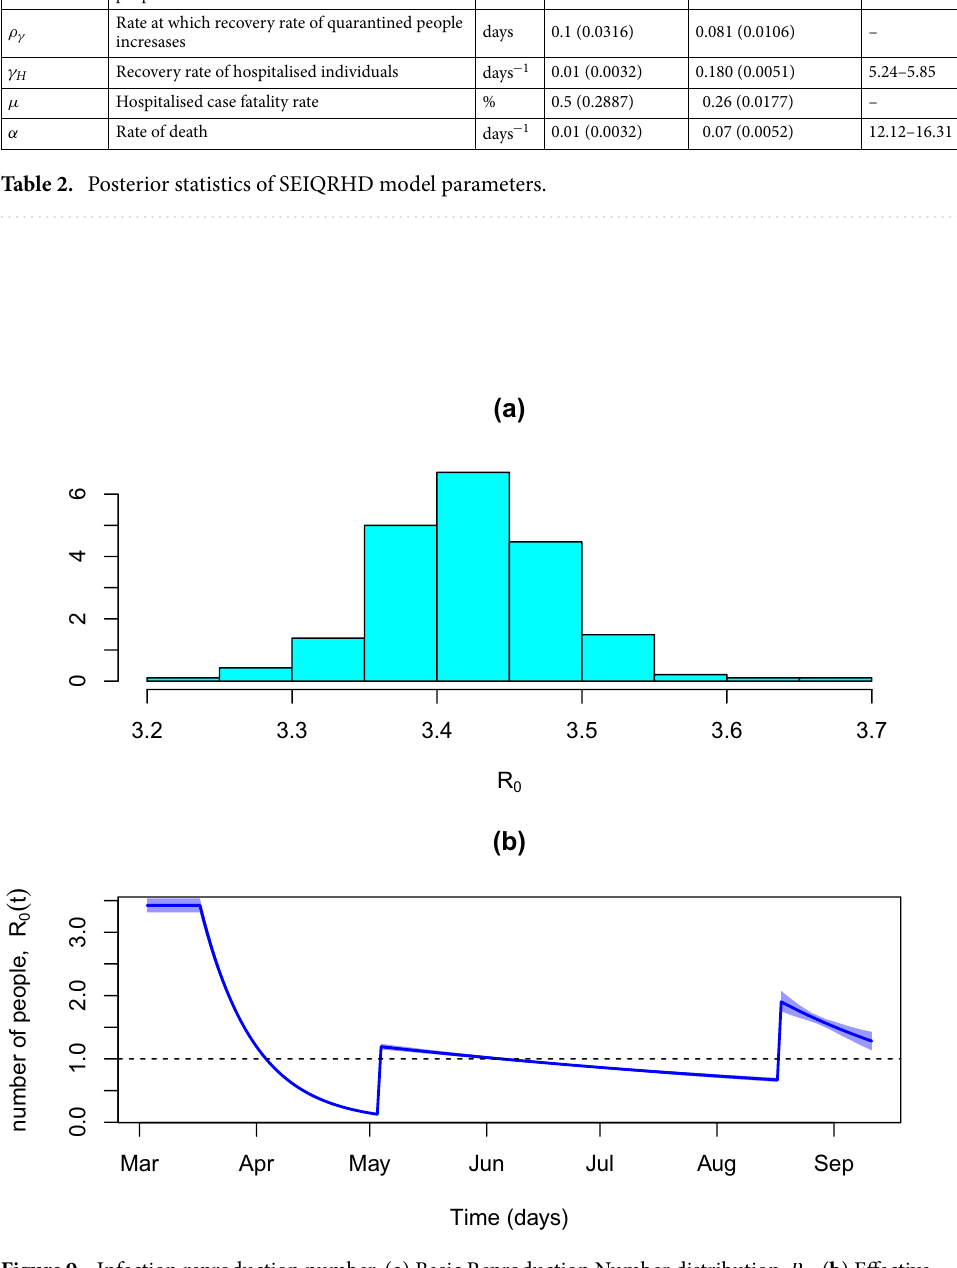
Figure 9. Infection reproduction number. ( a ) Basic Reproduction Number distribution, R 0 . ( b ) Effective reproduction number, R 0 ( t )